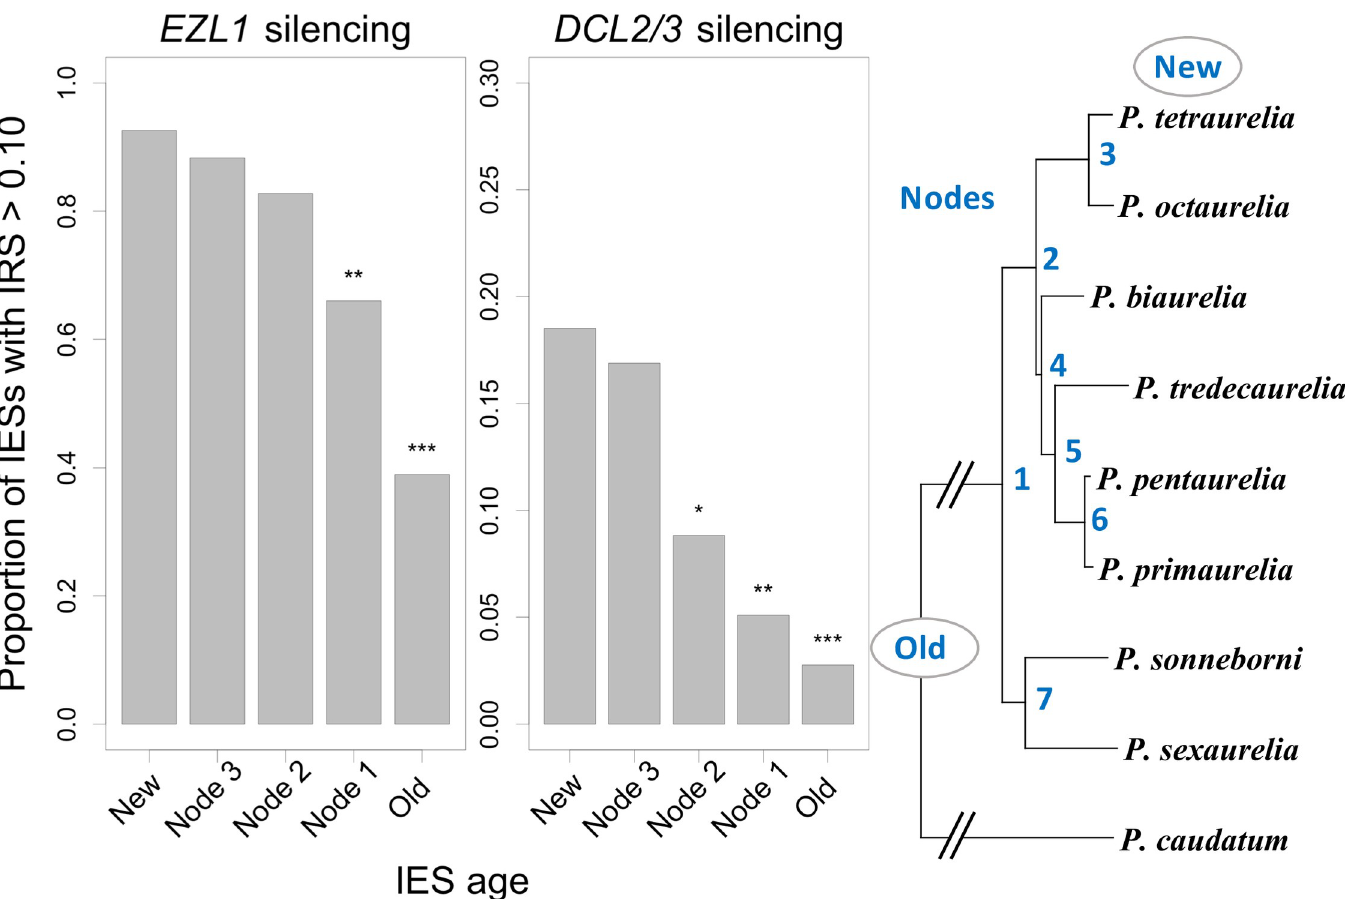
Fig 3. Old and young IESs rely on different excision pathways. The subset of IESs whose excision relies on histone marks or scnRNAs have been identified in P . tetraurelia by measuring their IRS upon silencing of EZL1 and DCL2/DCL3 [30]. Barplots represent the proportion of sensitive IESs (IRS > 10%) according to their age, for each silencing experiment. The age of an IES insertion is defined by the phylogenetic position of the LCA of species sharing an IES at the same site (New: P . tetraurelia - specific IES; Node n : The LCA corresponds to node number n in the species phylogeny; Old: The LCA predates the P . aurelia / P . caudatum divergence). The proportion of sensitive IESs among new IESs was compared to that of older ones by a chi-squared test ( � : p -value < 0.05; �� : p -value < 1e-3; ��� : p-value < 1e-6). The data underlying this figure may be found at https://doi.org/10.5281/zenodo.4836464. IES, internal eliminated sequence; IRS, IES retention score; LCA, last common